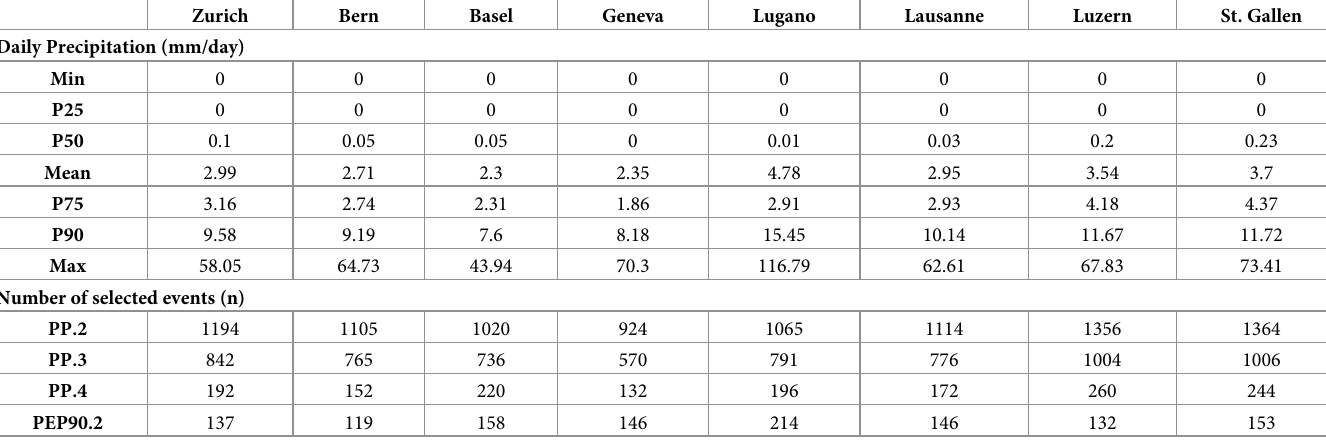
Table 2. Summary statistics of precipitation in eight cities of Switzerland between 2009 and 2019. Zurich